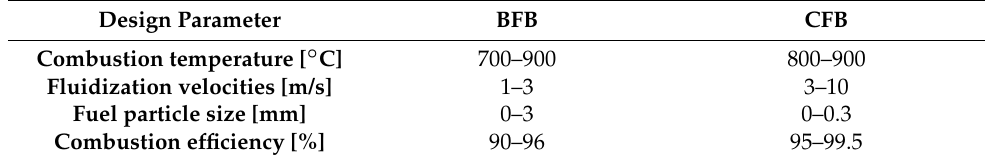
Table 5. Characteristics of bubbling fluidized bed (BFB) and circulating fluidized bed (CFB). Design